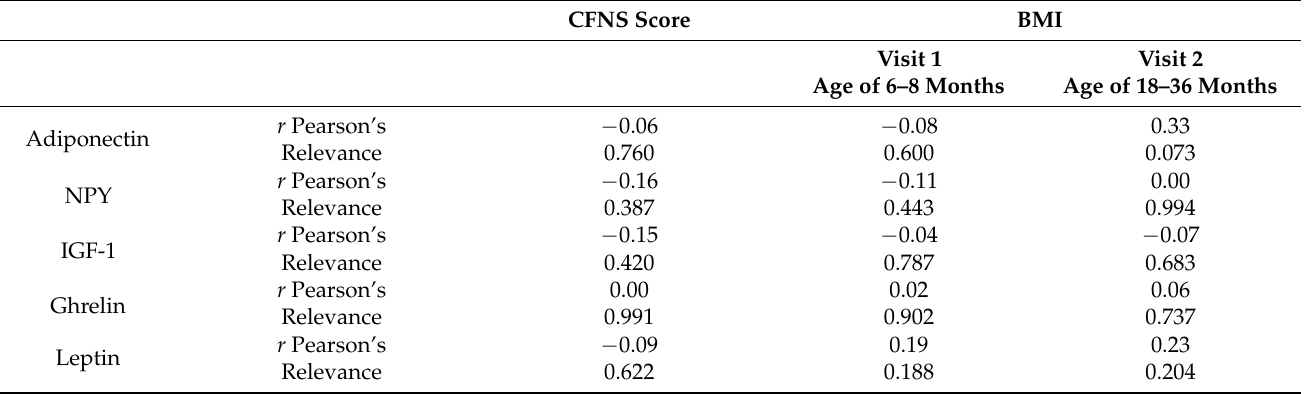
Table 8. Relationship between serum level of the gut-brain hormones and enteric peptides at the age of weaning and CFNS score at 18–36 months of age and BMI in prospective group.